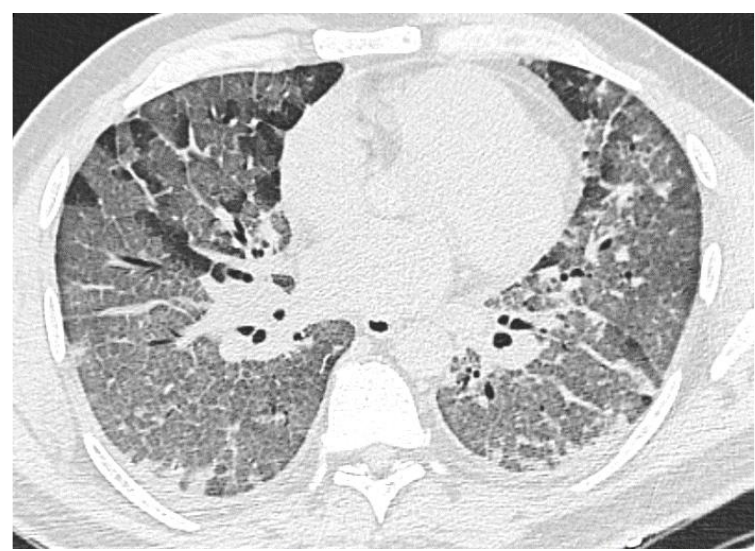
Figure 5. Crazy paving pattern.